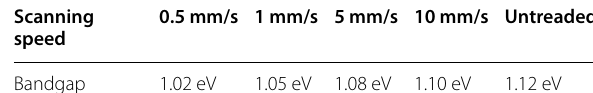
Table 2 The bandgap changes of scanning